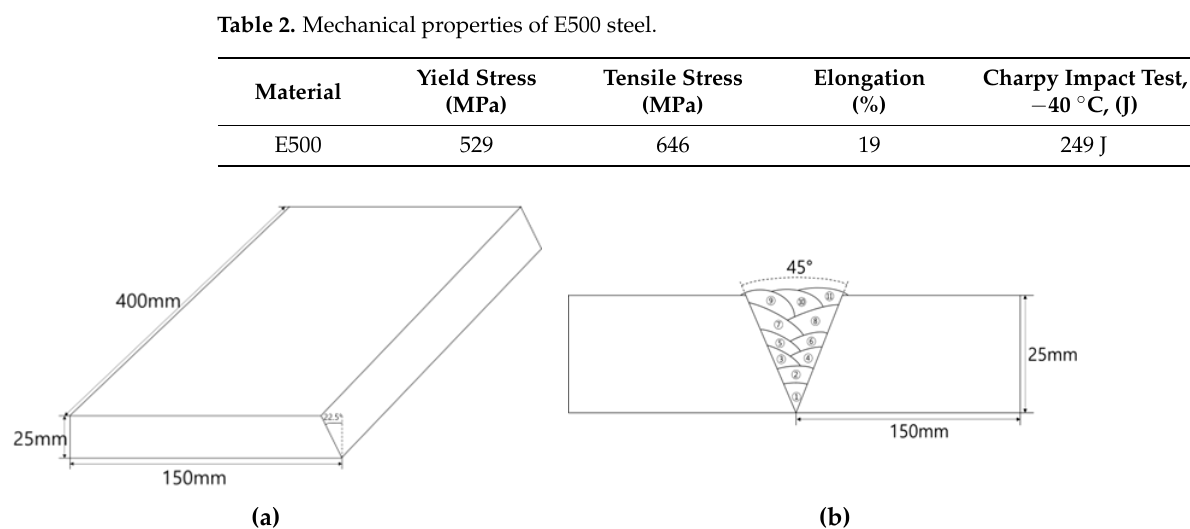
Figure 1. Dimensions and groove shape of the specimen. ( a ) Dimension of the specimen; ( b ) groove shape of the specimen.